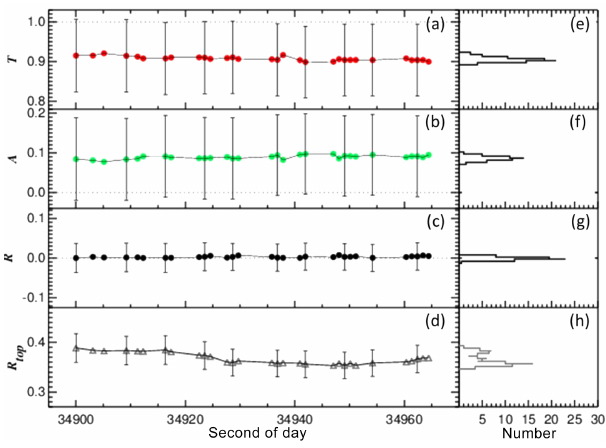
Figure 8. Time series of (a) transmissivity, (b) absorptivity, and (c) reflectivity (at 1640nm) for the cirrus layer between 9.0 and 9.2km altitude on 30 August 2013. The associated cloud top albedo is plotted in (d) . The vertical bars represent the errors due to mea- surement uncertainties. Panels (e) – (h) show the histograms, respec-